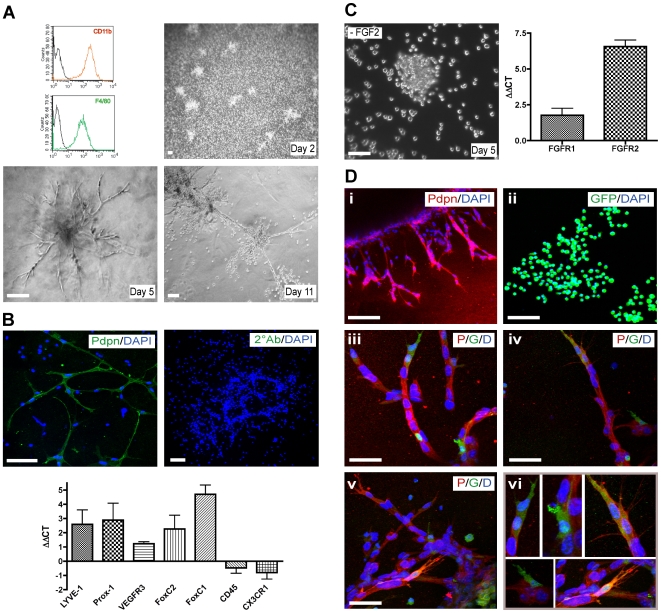
Bone marrow-derived-macrophages form and contribute to lymphatic-like structures in vitro.
(A) In vitro generated macrophages showed a specific marker expression profile (CD11b+/F4/80+) (upper left panel). Tube formation on Matrigel was monitored by phase-contrast microscopy. At day 2, macrophages formed clusters. Between days 3 and 15, they developed into cord-like structures with numbers of branches increasing over time. Scale bar: 100 µm. (B) Immunofluorescence staining against Podoplanin (Pdpn) revealed that macrophages having formed cord-like structures express Podoplanin whereas single cells do not. Staining of the tubular structures in the absence of any primary antibody was used as a control (2°Ab). DAPI stains nuclei (blue). Scale bar: 100 µm. Quantitative RT-PCR analysis revealed that upon tube formation, macrophages up-regulate lymphatic markers (LYVE-1, Prox-1, VEGFR-3, Foxc2, Foxc1) and down-regulate hematopoietic/myeloid marker (CD45, CX3CR1). ΔΔCT corresponds to the difference between the normalized CT values of macrophages forming tubes (day 8) and macrophages not having yet formed tubes (day 1). (C) FGF-2 is required for the formation of cord-like structures by macrophages, as its specific exclusion from culture medium abrogated this process (left panel). Furthermore, analysis of mRNA levels revealed up-regulation of FGF receptors -1 and 2 during cord formation. (D) Immortalized Podoplanin+ murine lymphatic endothelial cells (SV-LEC) (i), GFP-labeled bone marrow-derived-macrophages (ii), and mixed cultures of macrophages and SV-LEC (iii-vi) were seeded in Matrigel. At day 5, cells were stained for Podoplanin (red) and analyzed by confocal microscopy. Mixed cultures demonstrate that bone marrow-derived macrophages contribute to SV-LEC-mediated cord formation: GFP+ cells (green) are found integrated into Podoplanin+ cord-like structures (iii–vi). Note the preferential integration of bone marrow-derived macrophages at the tips and branch points of sprouting cord-like structures formed by SV-LEC (magnified in panel vi). DAPI stains nuclei (blue). Scale bars: 100 µm (i–ii) and 50 µm (iii–vi).